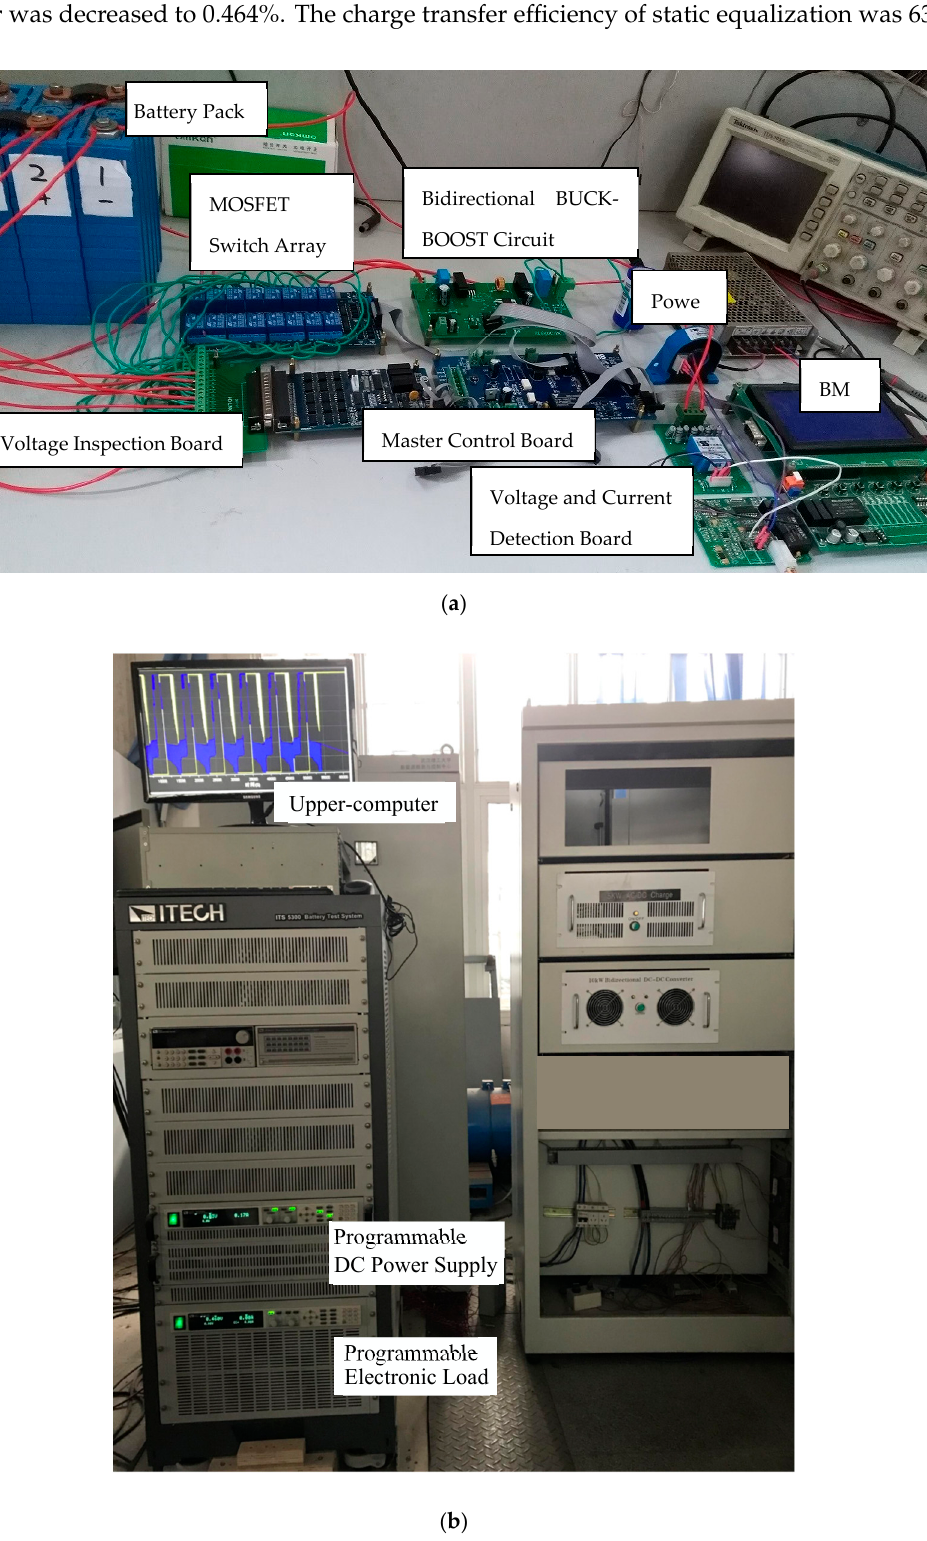
Figure 9. ( a ) Balancing experiment test bench, ( b ) battery test system.